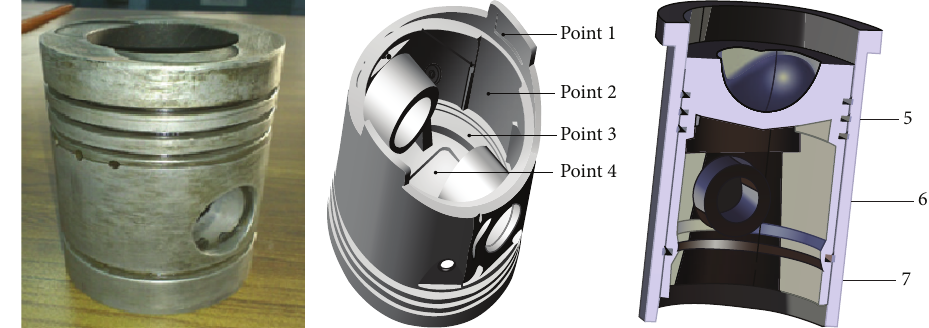
Figure 2: AV1 diesel engine piston.